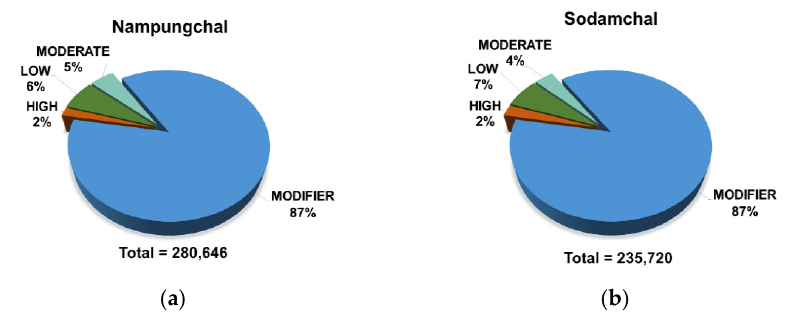
Figure 7. Distribution of the variants by impact consisting of high, moderate, modifier, and low: ( a ) Nampungchal and ( b ) Sodamchal.